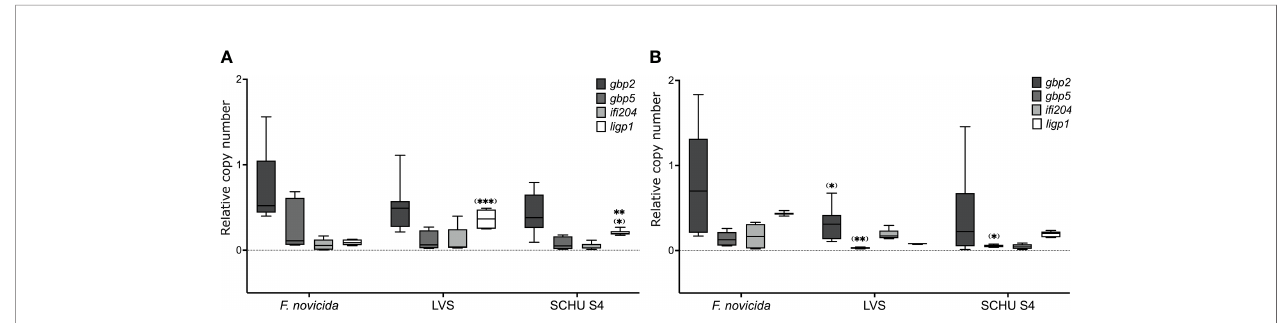
FIGURE 2 | RT-PCR analysis of gbp2 , gbp5 , i fi 204 and ligP expression in cultures with wild-type BMDMs after addition of IFN- g and infected with indicated F. tularensis strains using an MOI of 100. The box plots represent relative copy number of mentioned genes 4 h (A) and 8 h (B) . Signi fi cances within parenthesis indicate comparisons to F novicida -infected BMDMs. * P < 0.05, ** P < 0.01, *** P <